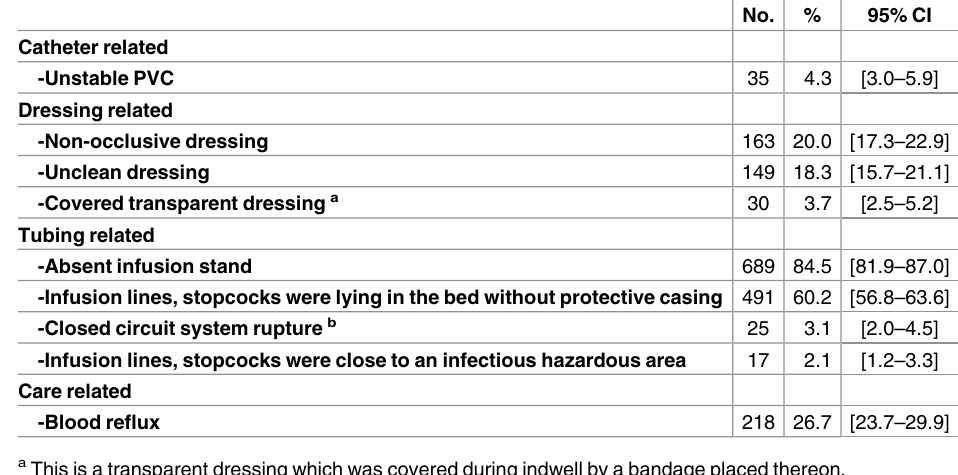
Table 3. Frequency of quality breaches observed at least once during dwelling time in 815